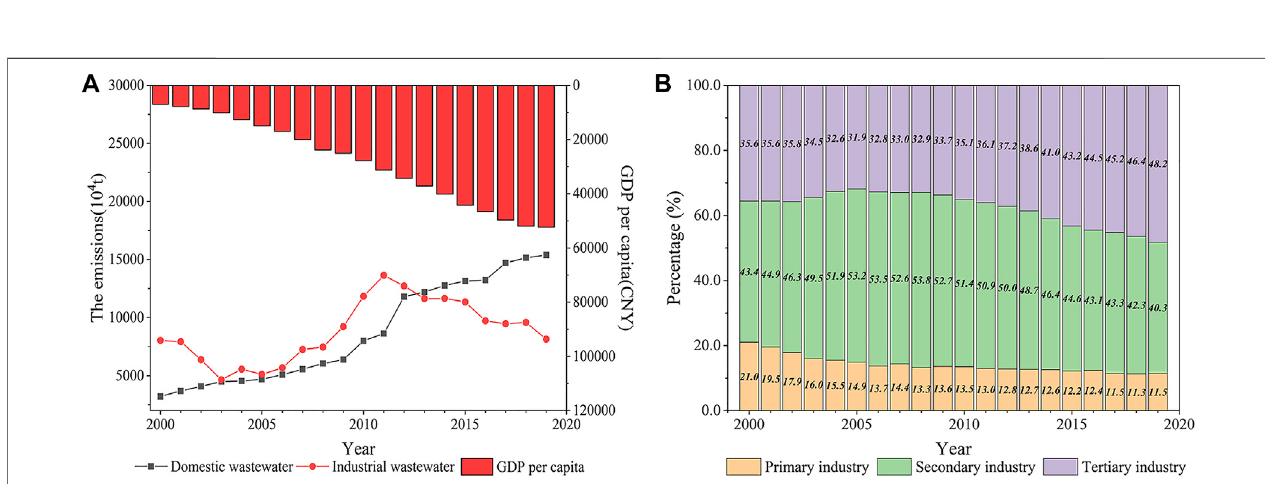
FIGURE 6 | Capacity ofwater storage and water treatment from 2000 to 2019 in each basin of the ENLB (A) : sluices and rubber dams, (B) waste water treatment plants, (C) constructed wetlands).